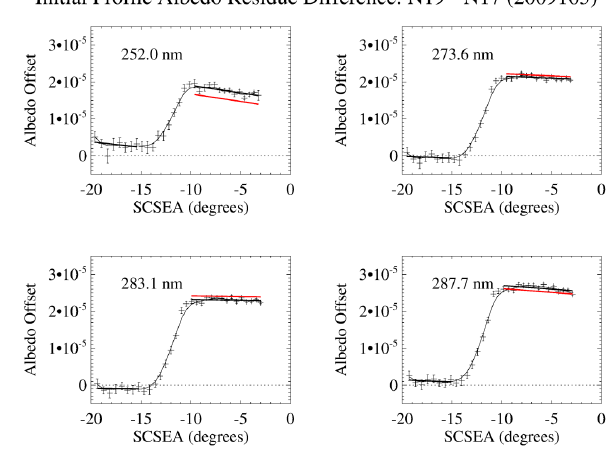
Fig. 4. SBUV/2 instrument in the laboratory. Pieces of anodized SBUV/2 instrument in the laboratory. Pieces of anodized plates are installed 3 plates are installed surrounding the SBUV/2 aperture as light baf- surrounding the SBUV/2 aperture as light baffles. The diffuser deployment mechanism has a 4 fles. The diffuser deployment mechanism has a cylindrical axle that cylindrical axle that reflects roof light into the viewer’s eye. Courtesy Ball Aerospace and 5 reflects roof light into the viewer’s eye. Courtesy of Ball Aerospace Technologies Corp. 6 and Technologies Corp.